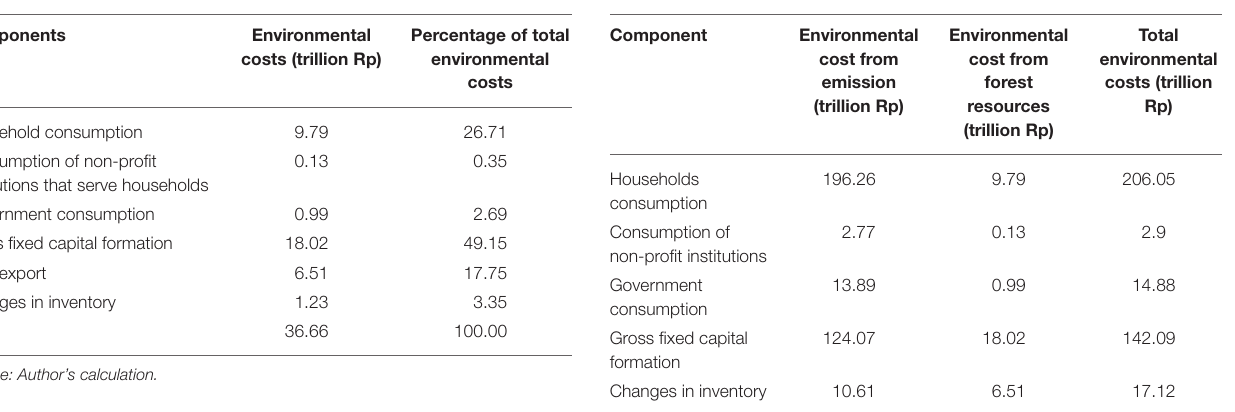
TABLE 6 | Total environmental costs due to final demand in Indonesia in 2010 (Trillion